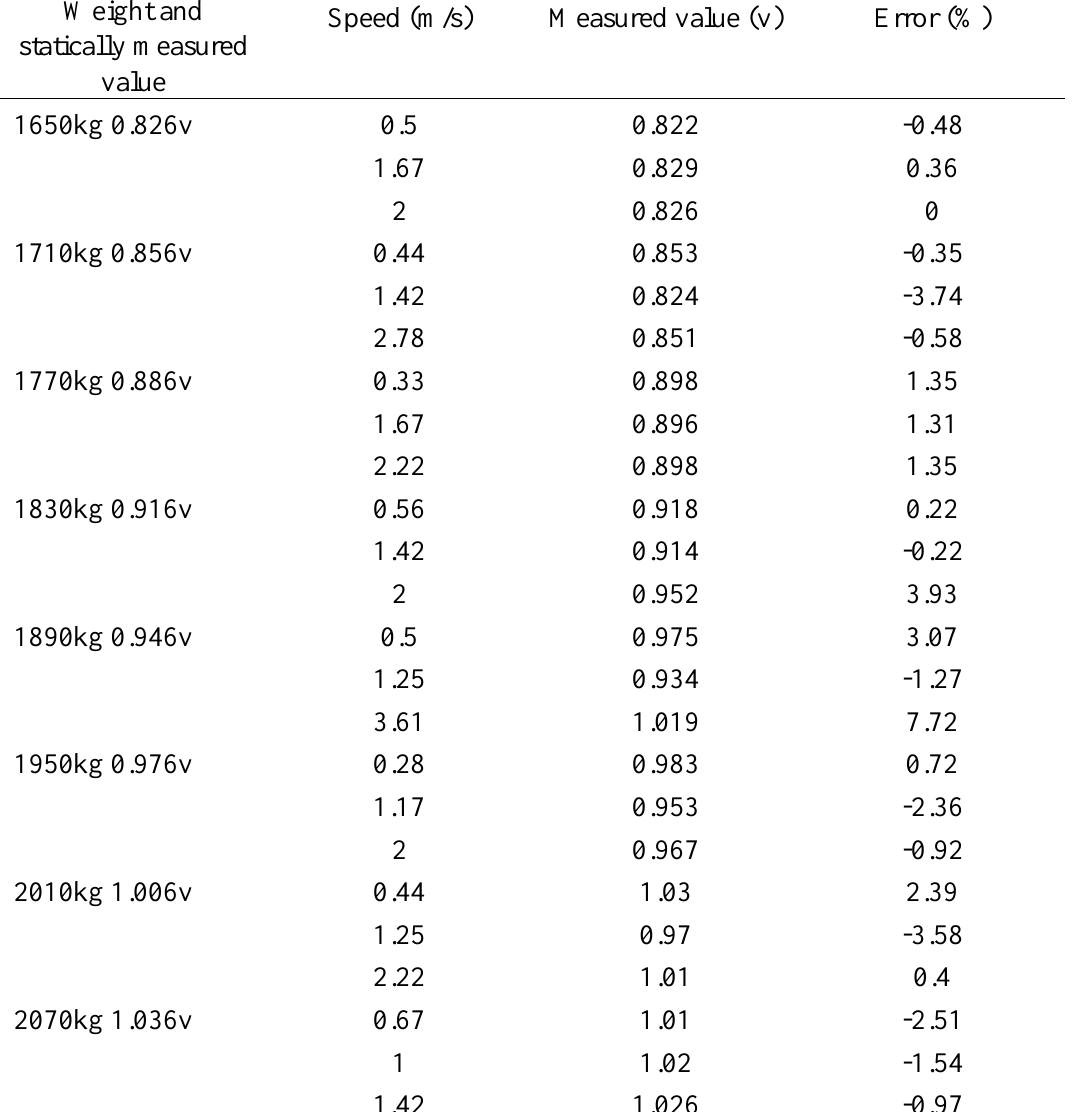
Table 2. Measurement results and accuracy of WIM